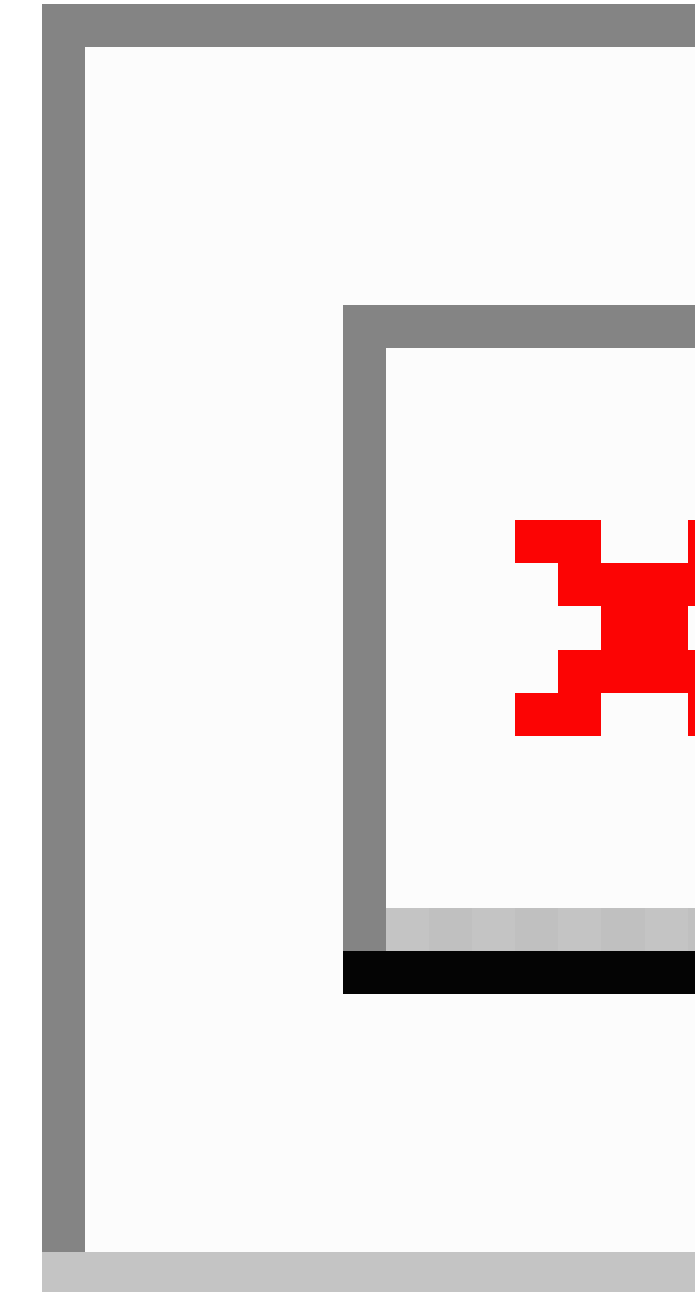
Figure 3. Change in global motivational interviewing scores after